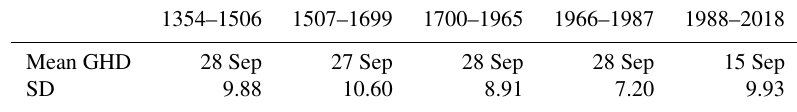
Table 3. Mean GHD and standard deviation for various sub-periods of the Beaune GHD homogenised time